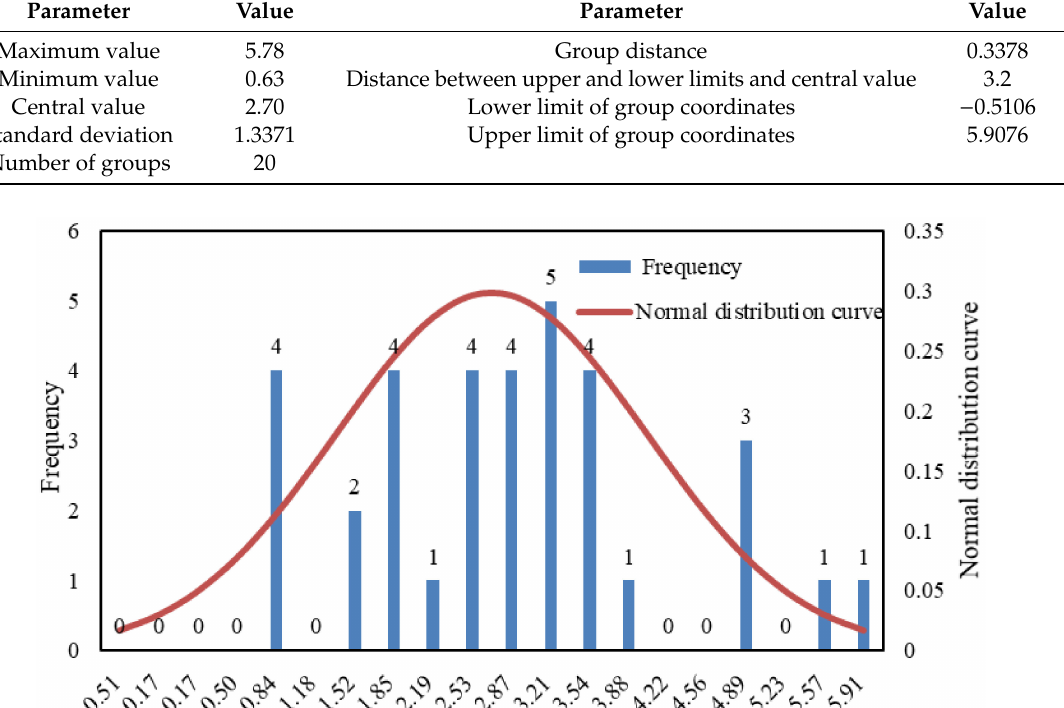
Figure 3. Normal distribution of water recovery